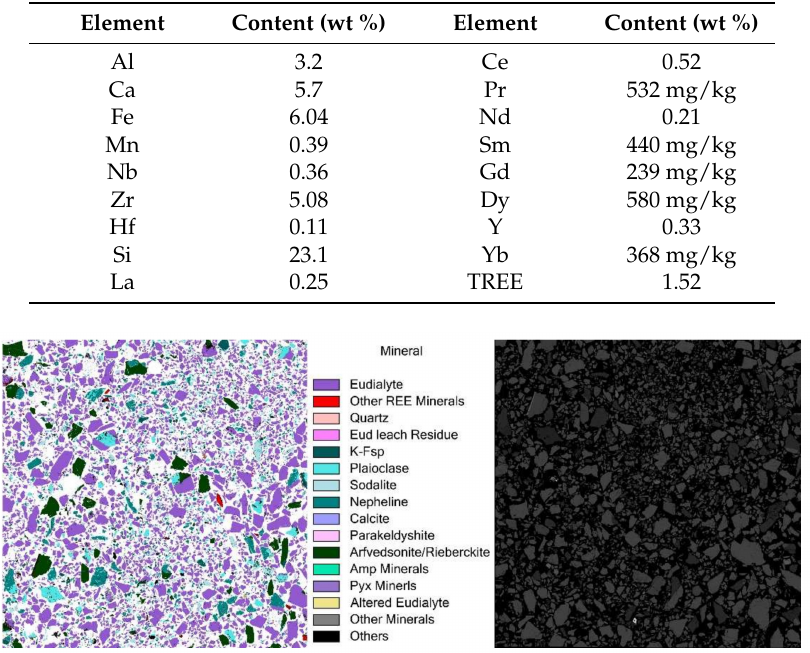
Figure 4. QEMSCAN analysis of eudialyte concentrate (( left ) false color image after evaluation, ( right ) initial BSE-image).